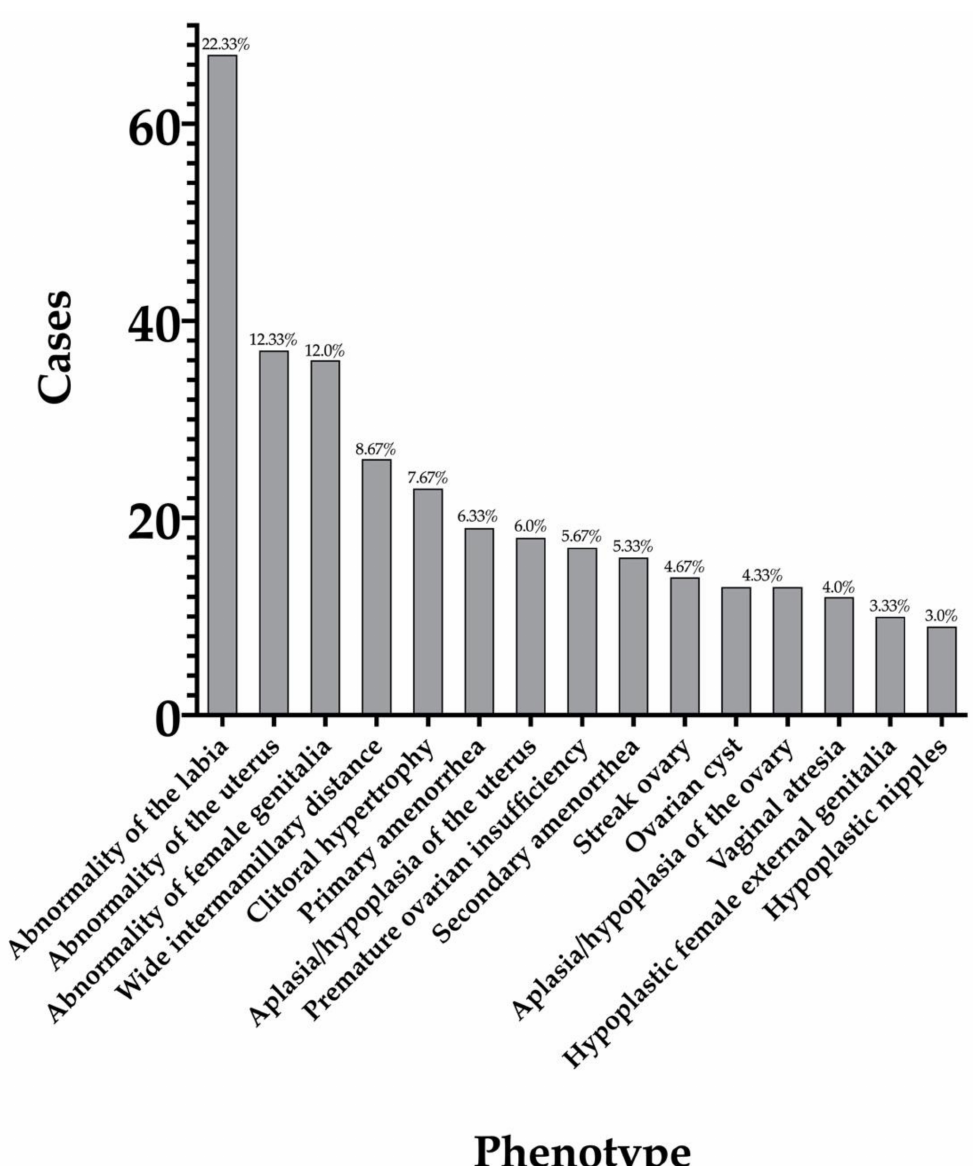
Figure 2. Most frequent DSD phenotypes seen in patients with atypical female